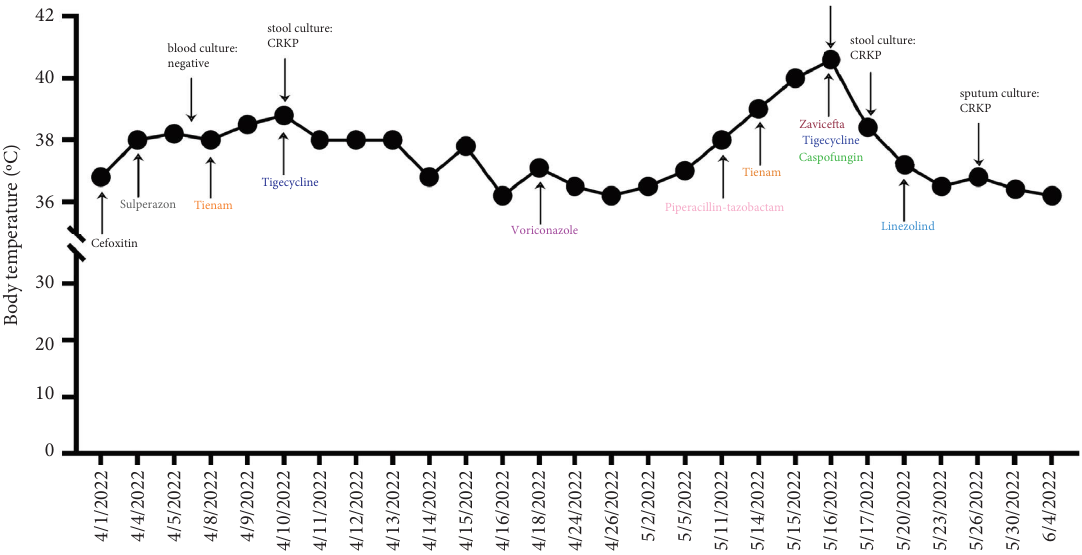
Figure 1: Anti-infective therapy of case